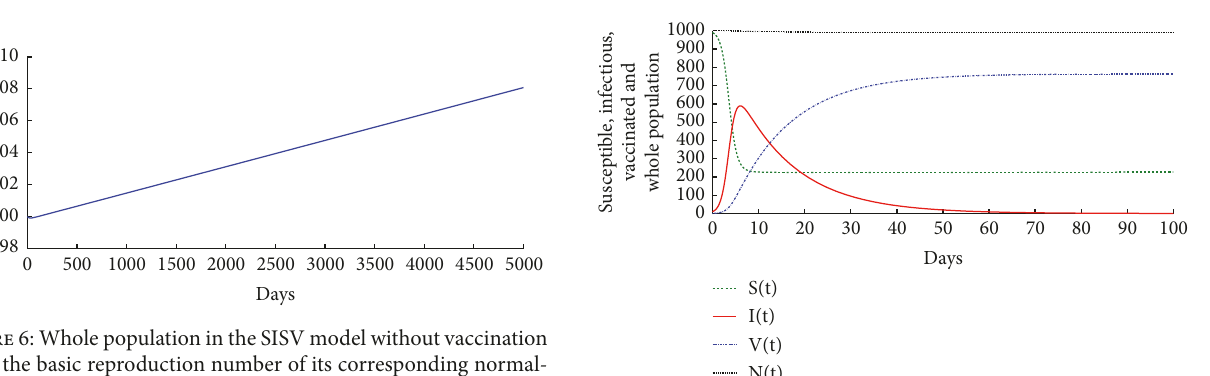
Figure 5: Susceptible subpopulation and whole population in the SISV model without vaccination when the basic reproduction number of its corresponding normalized SISV model is 𝑅 0 = 0.878 .